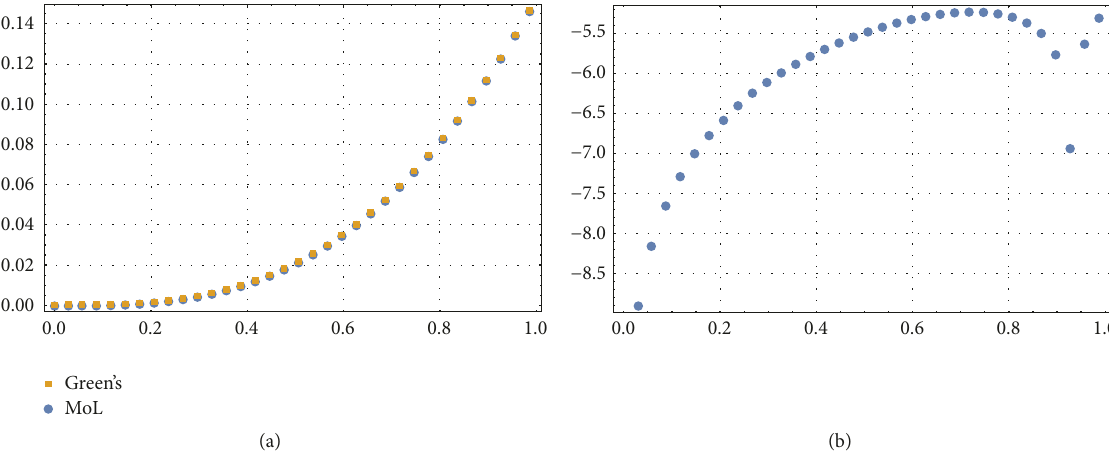
Figure 9: Discrete plot of 𝑤 and 𝑤 MoL (a) and Er (b) against 𝑡 ∈ [0, 1] for 𝑓(𝑡) = sin (𝑡) : hyperbolic Green’s